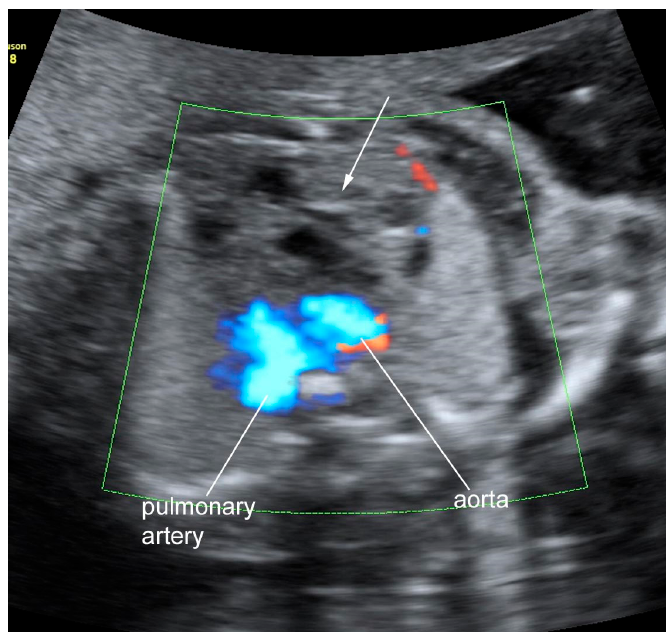
Figure 1. Ultrasound image of the teratoma: transverse view of the fetal chest at 22 weeks; a complex mass with solid and liquid components was seen in the upper and anterior part of the thorax (arrow).